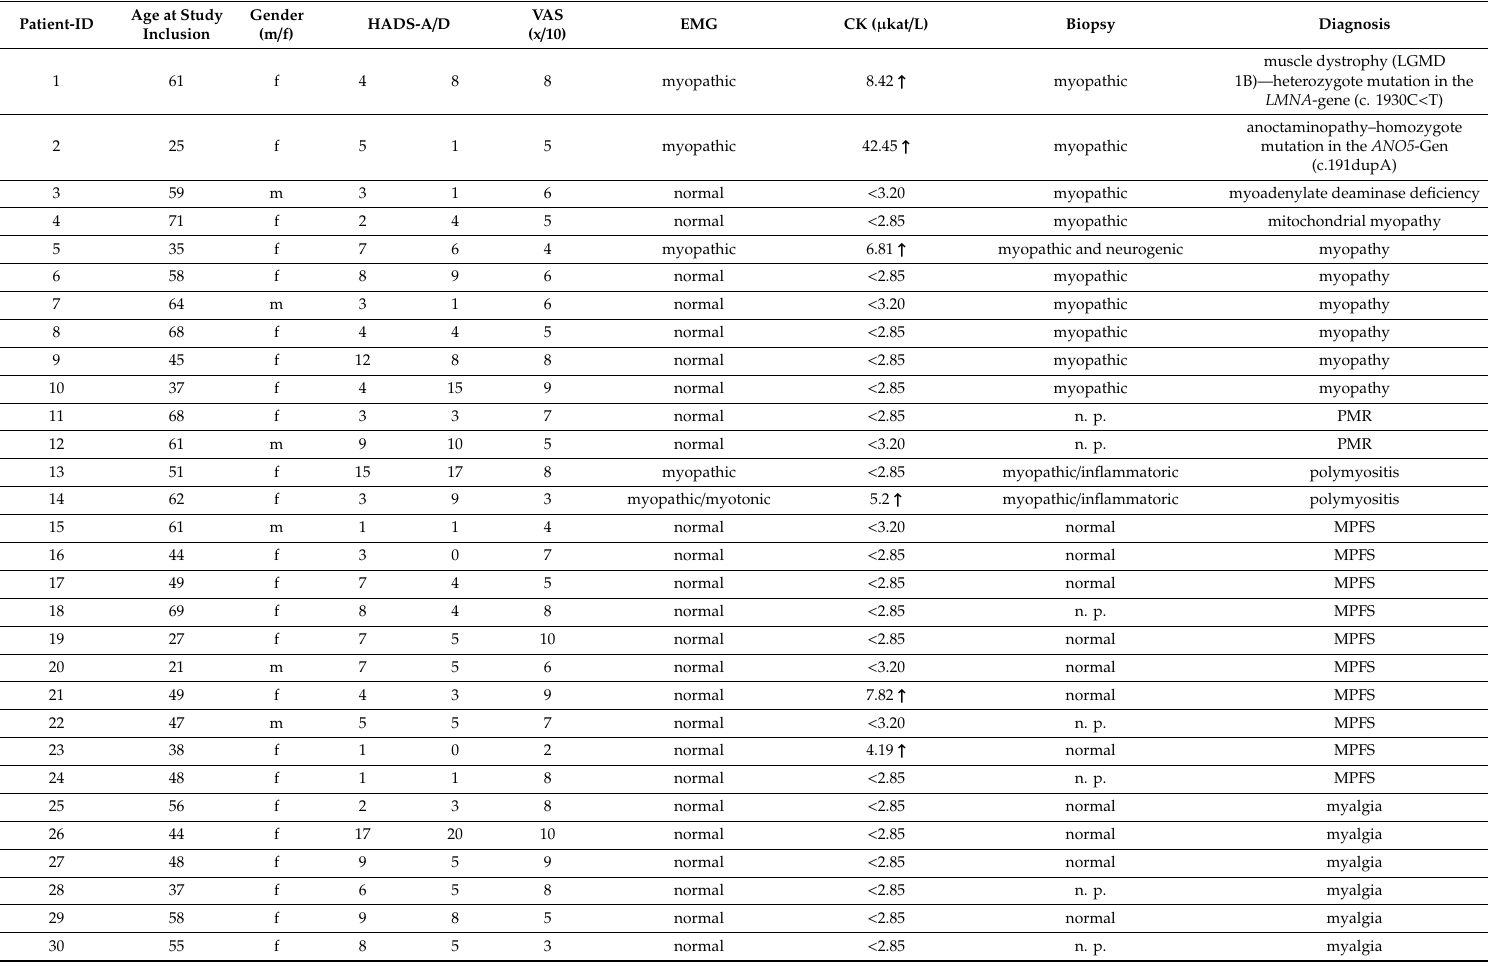
Table 1. Demographic and clinical information, HADS results, and VAS-ranking such as diagnosis of patients included in the study, norm values for CK (creatine-kinase): female < 2.85 µ kat / L, male < 3.20 µ kat / L. n.p. = not performed, PMR = polymyalgia rheumatica, MPFS = muscular pain fasciculation